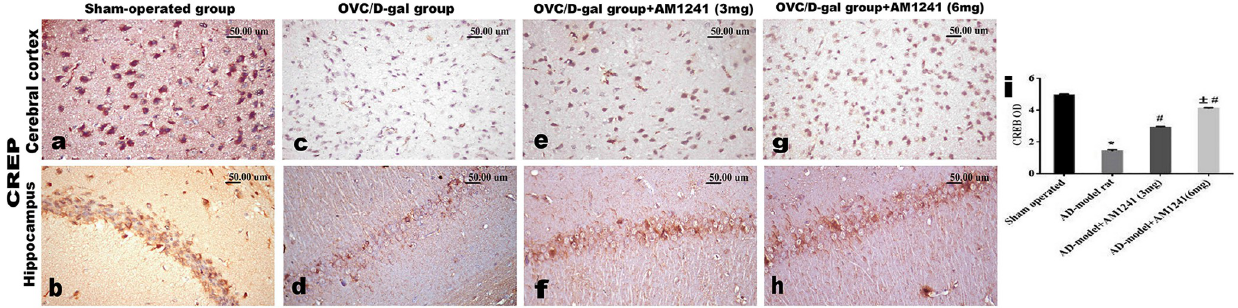
Fig 8. Photomicrographs of CREB immune-stained sections of frontal cortex and hippocampus. (a-b) Sham-operated group showing marked expression of CREB. (c-d) OVC/D-gal group showing diminished CREB expression among the neuronal cells. AD-model rats’ which treated with AM1241, (e-f) 3mg/kg and (g-h) 6mg/kg showing restored boosted expression of CREB. (i) Image analysis software for quantification of the positive expression of CREB (data were analyzed by using one way ANOVA followed by Tukey’s post hoc test. Values expressed as mean ± SE (n = 5 rats/group). � , #, and ± statistically significant different at P < 0.05, where; � statistically significant different comparing with control group, # statistically significant different comparing with OVC/D-gal group, ± statistically significant different comparing with AM1241 (3mg/Kg).